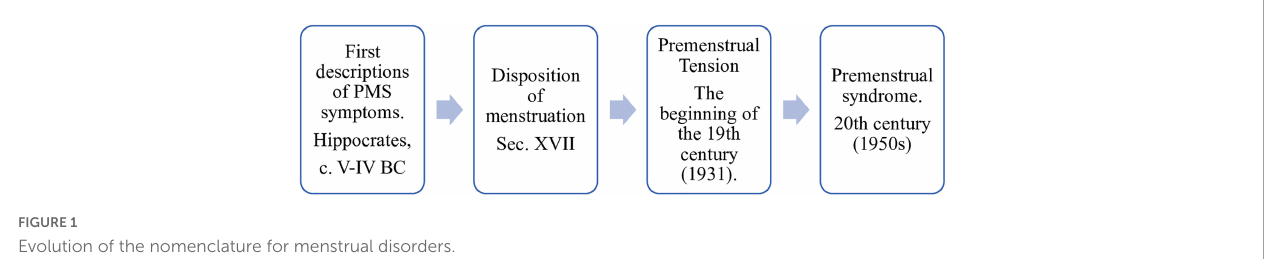
FIGURE1 Evolution of the nomenclature for menstrual disorders.